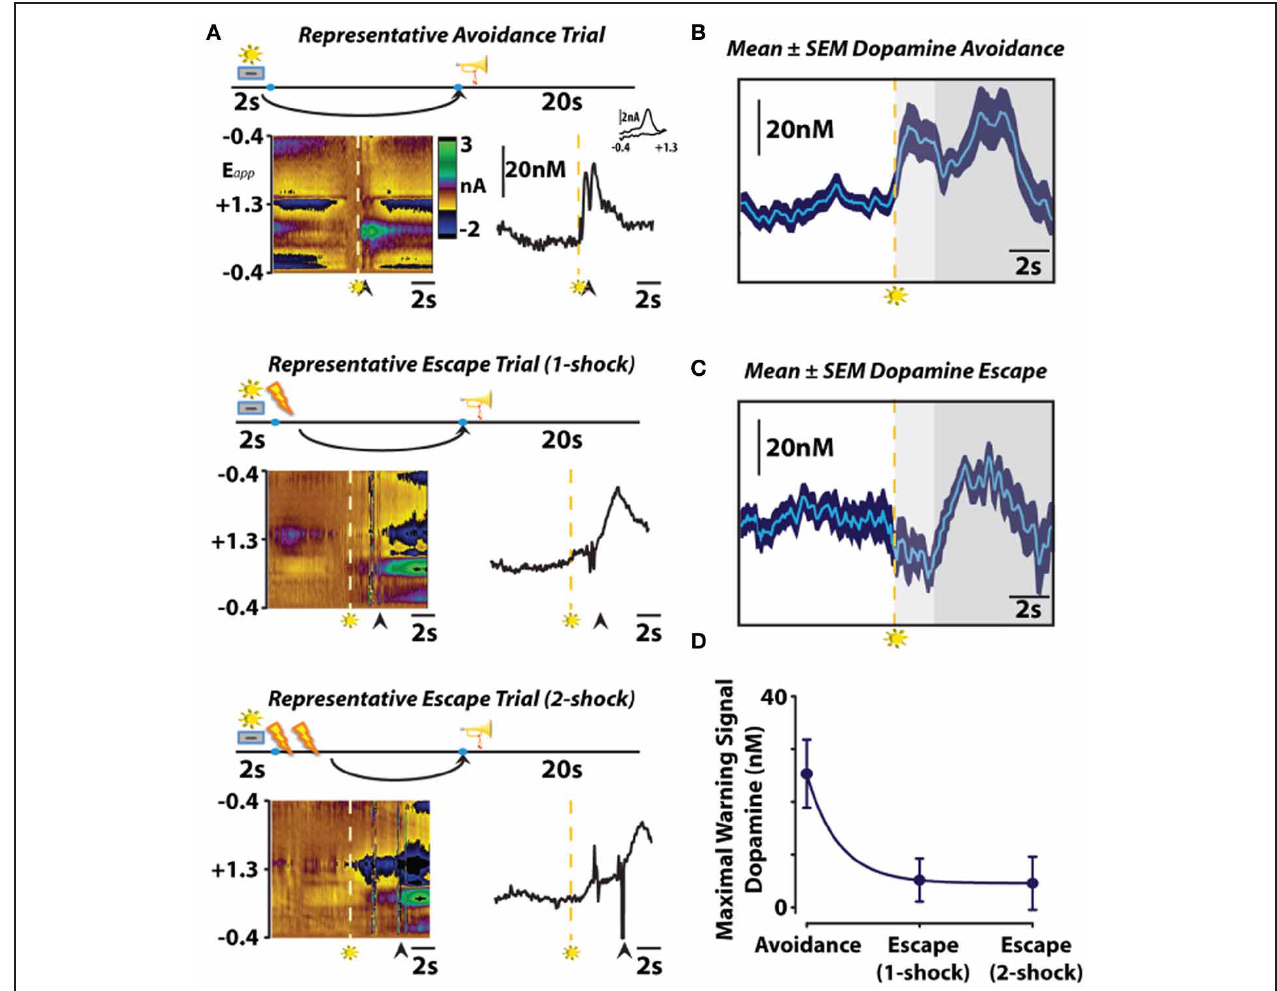
FIGURE 2 | The role of subsecond dopamine release during conditioned avoidance. (A) Changes in subsecond dopamine release observed in different response types observed in a single session. Representative color plots (left) and dopamine concentration traces (right) show avoidance (top), one-footshock escape (middle), and two-footshock escape (bottom) responses. Left, the y -axis represents the scan potential (E pp , V) applied to the electrode, the x -axis represents time, and the z -axis represents current. Inspection of the color plot allows for the identification of dopamine over time. Dopamine can be identified in the color plot by assessing for changes in current at the oxidation ( + 0.6V) and reduction ( − 0.2V) potentials for